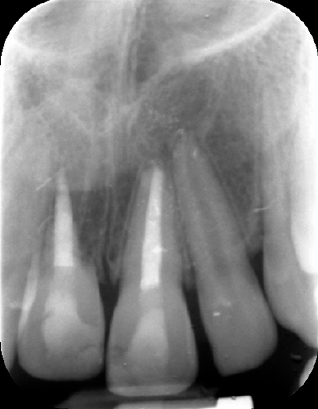
Figure 8. Radiographical follow-up 24 months post-trauma.